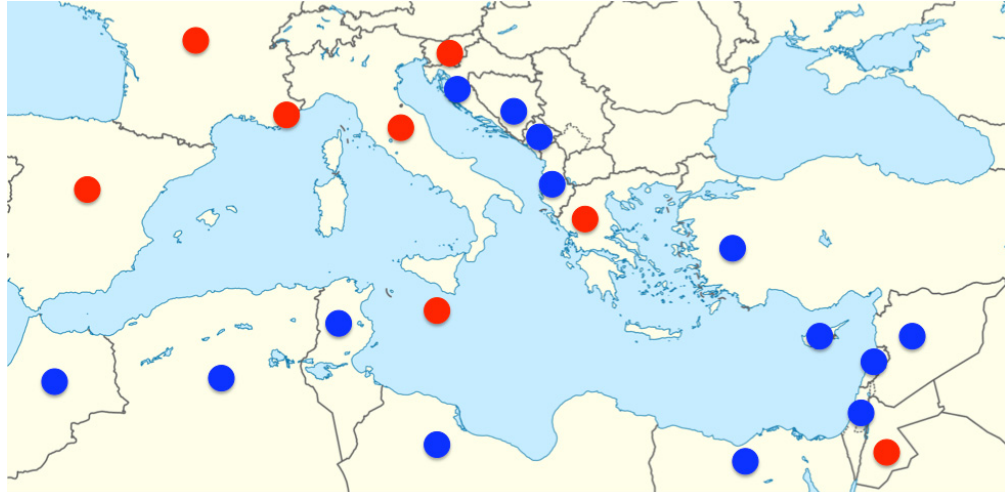
Figure 1. Map of the Mediterranean Sea (Nordwest, using World Data Base II data) [14]. Developed countries (red circles): France, Greece, Israel, Italy, Malta, Monaco, Slovenia, and Spain. Other countries (blue circles): Albania, Algeria, Bosnia-Herzegovina, Croatia, Cyprus, Egypt, Lebanon, Libya, Montenegro, Morocco, Palestine, Tunisia, and